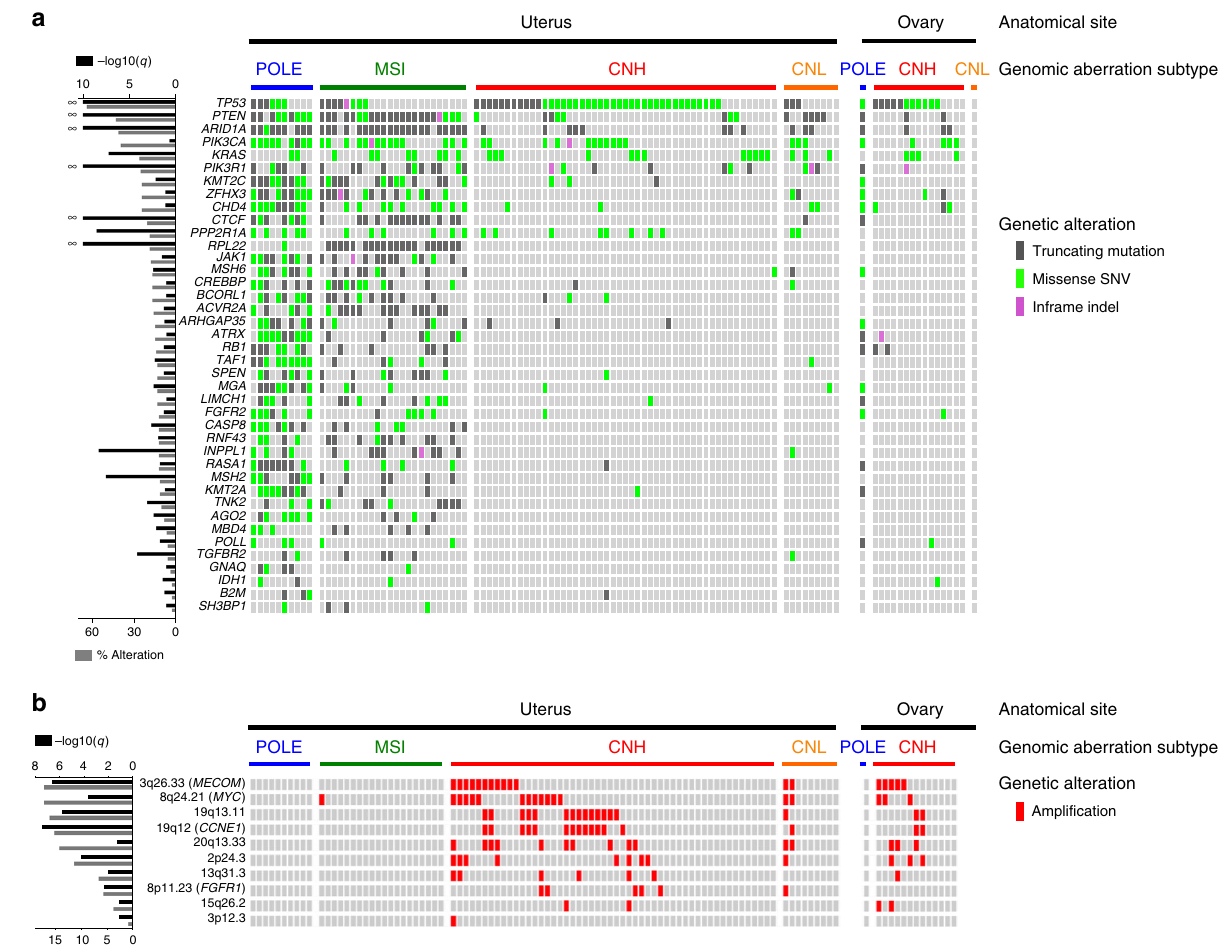
Fig. 3 Somatic driver genes in carcinosarcoma (CS) subtypes. a Somatic driver SNVs and indels. Driver genes were computed by IntOGen 54 using somatic SNVs and indels (from target panel or exome sequencing data focusing on 596 genes of the target panel; n = 109). The mutations are presented with Oncoprint according to CS genomic subtype in descending order of mutational frequency in the cohort. Driver genes with statistical signi fi cance of q < 0.02 are shown. Mutational frequency in the cohort (gray bar) and q -value for each driver gene (black bar) are shown on the left. Color code is as follows: somatic missense SNV, yellow green; somatic truncating mutation, gray; and somatic in-frame indel, lilac. b Somatic driver CNVs. CNV driver genes were detected by GISTIC 34 using CNVs called (from SNP6 array data; n = 105) 52 . Mutational frequency in the cohort (gray bar) and q -value for each driver gene (black bar) are shown on the left. Ampli fi cation (CN ≥ 6) is shown in red 53 . We do not show copy number gain (CN = 3, 4, or 5) or loss (CN = 1). Note that only ampli fi cation was detected, and no homozygous deletion (CN = 0). CN; copy